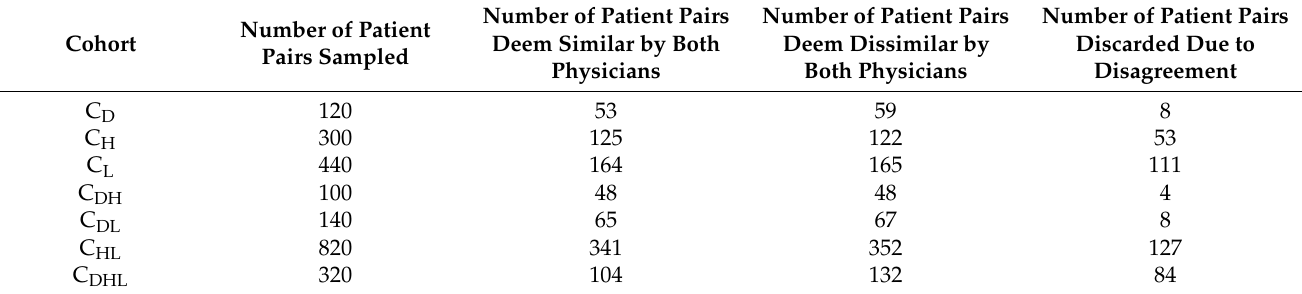
Table 4. Statistics of patient pairs manually annotated in each